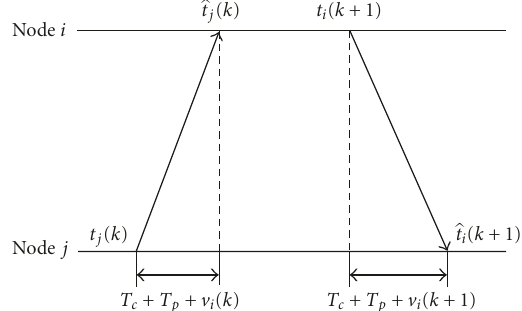
Figure 3: DCTS algorithm with Gaussian delay during local time information